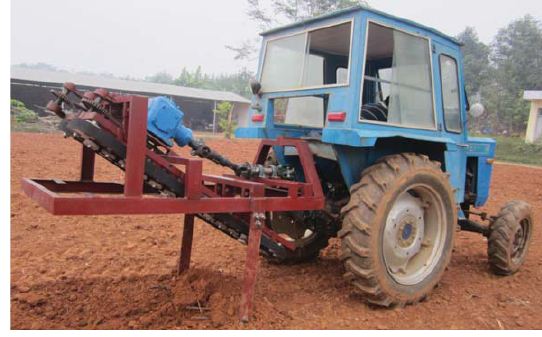
Fig. 10. Cassava harvester prototype’s field